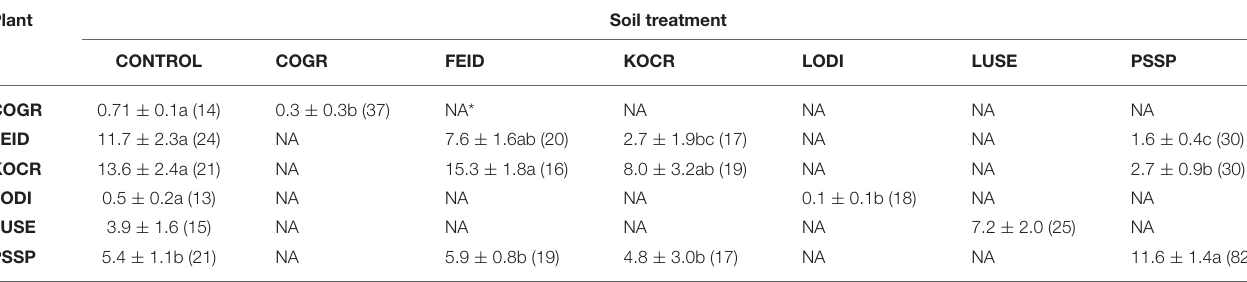
TABLE 2 | Ground cover (%) of six native plants on different soil treatments. Plant Soil treatment